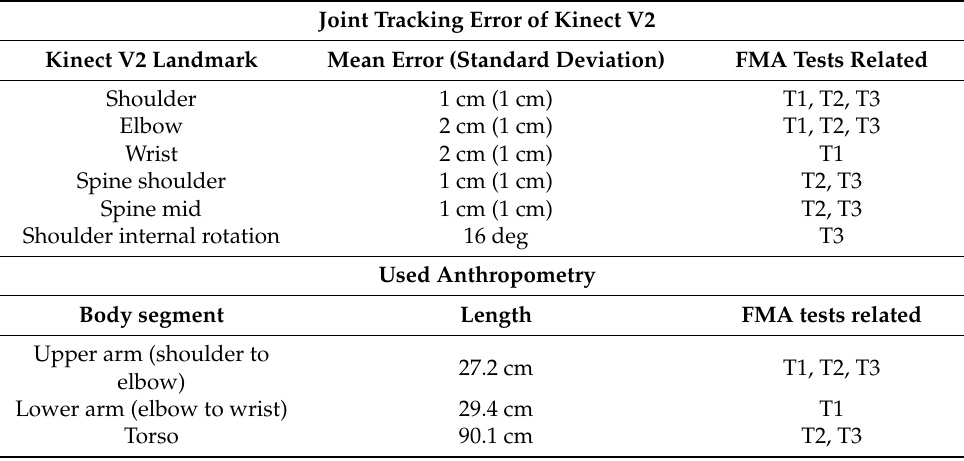
Table 5. Information used to estimate fuzzy result error due to sensor inaccuracy.